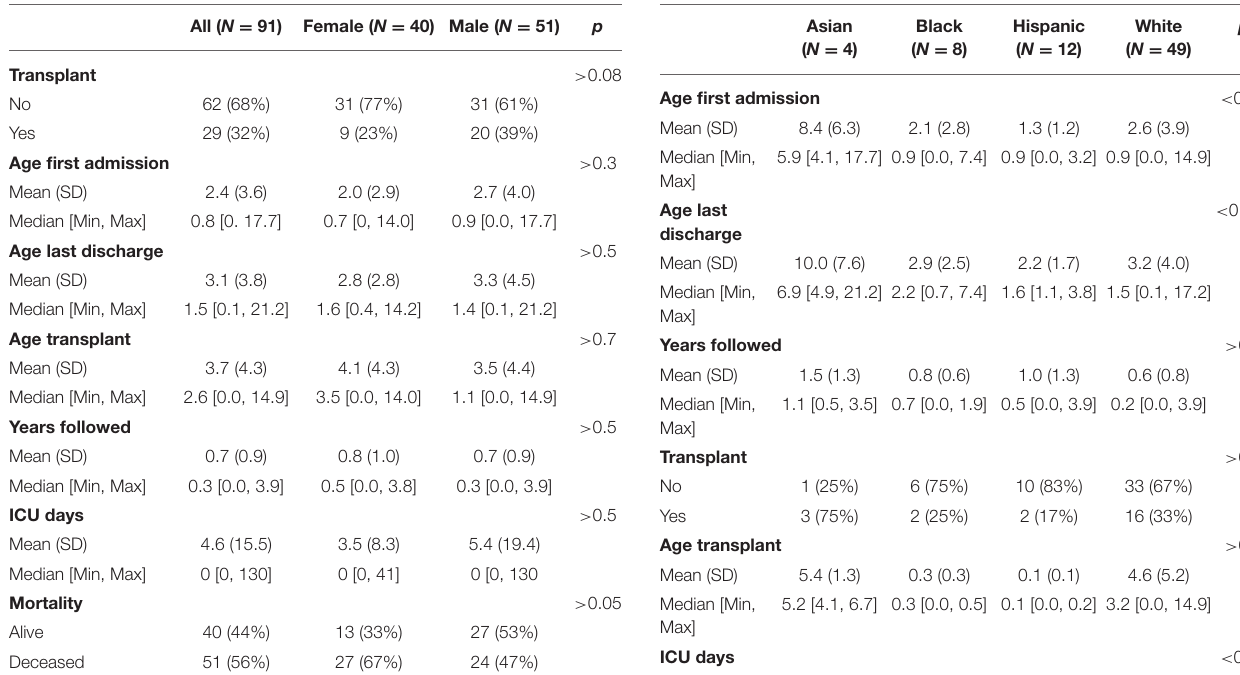
TABLE 4 | Race and ethnicity in KD